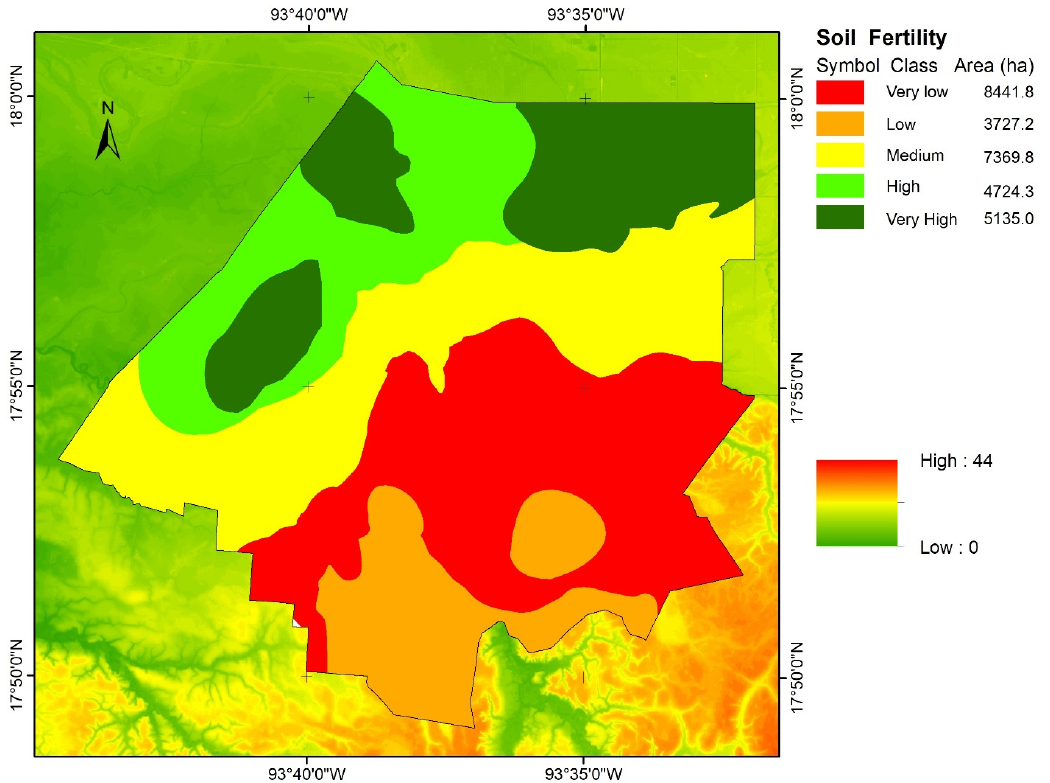
Figure 5. Model of soil fertility map. To the center and east to west is the zone of medium soil fertility, right in the transi- tional zone between the plains and hills (Figure 5). In the center and to the south in the hills, the surface of very low fertility (Acrisols) is located, with the most acidic pH values and shallow CEC values. The two low fertility class areas are situated to the south. 4. Discussion 4.1. Soils, Fertility, and Management The very acidic pH values of the soils of the hills correspond to Acrisols [15,17]. In these plots, the application of amendments with dolomite is recommended to add calcium and magnesium. Another option is the application of dissolved organic matter-type vi- nasse that also contains high concentrations of K, Ca, Mg, and other nutrients [39]. The application of nixtamalization wastewater is also recommended because it contains high calcium concentrations. The objectives of applying mineral, organic, or mixed amendments must be to in- crease the pH, decrease the exchangeable aluminum, and increase the content and avail- ability of nutrients such as Ca, Mg, and K, focusing on the balance among them [13,15]. The elaboration of maps considering the complete soil profile is not joint in tradi- tional agricultural studies or precision agriculture studies. Figure 6 shows five soil profiles of the study area in which the arable layer is indicated with a yellow line; everything be- low the yellow line is left out of conventional studies. The soil-ecological evaluation con- siders two significant advantages: (a) the transformation of units when passing from con- centration to quantity (units per surface) per horizon; (b) the use of a complete soil profile